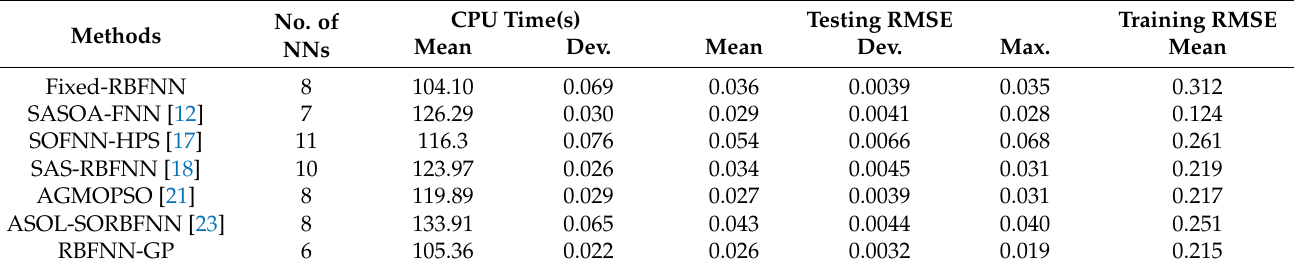
Table 2. Comparison results with other self-organizing methods.